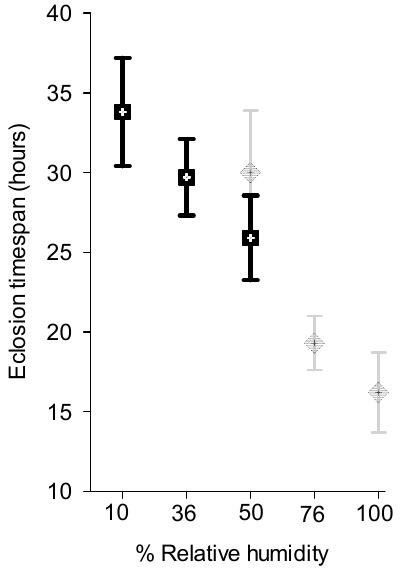
Table 1. Eclosion and initiation of excavation behavior by neonates of Cactoblastis cactorum.